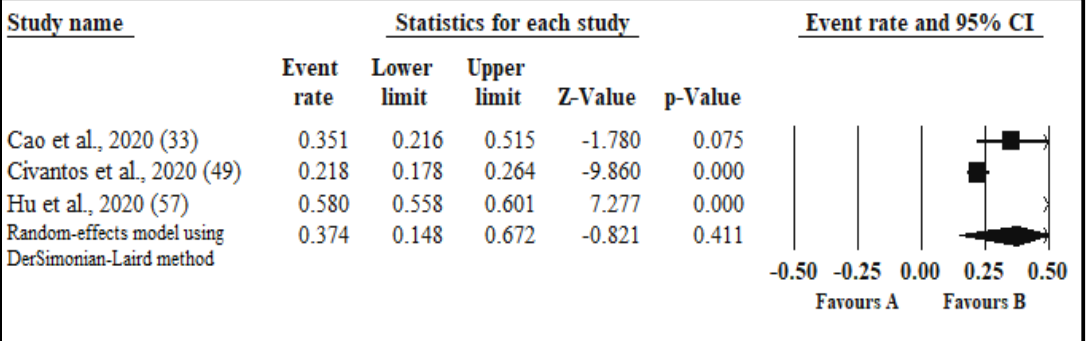
Figure A5. Forest plot for the studies on the prevalence of burnout among healthcare workers . The squares and horizontal lines correspond to the study-specific event (anxiety) rates and 95% confidence intervals (CIz). The diamond represents the pooled prevalence and 95% CI of the overall population. The overall pooled burnout using a random effects DerSimonian-Laird method was 37.4% (95% CI: 14.8–67.2).